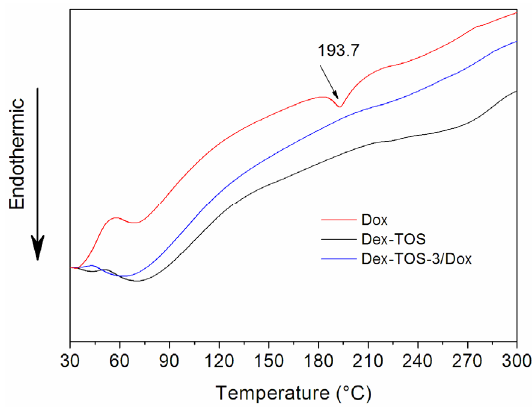
Figure 5. Differential scanning calorimetry (DSC) spectra of Dox, Dex-TOS, and Dex-TOS-3/Dox micelles.